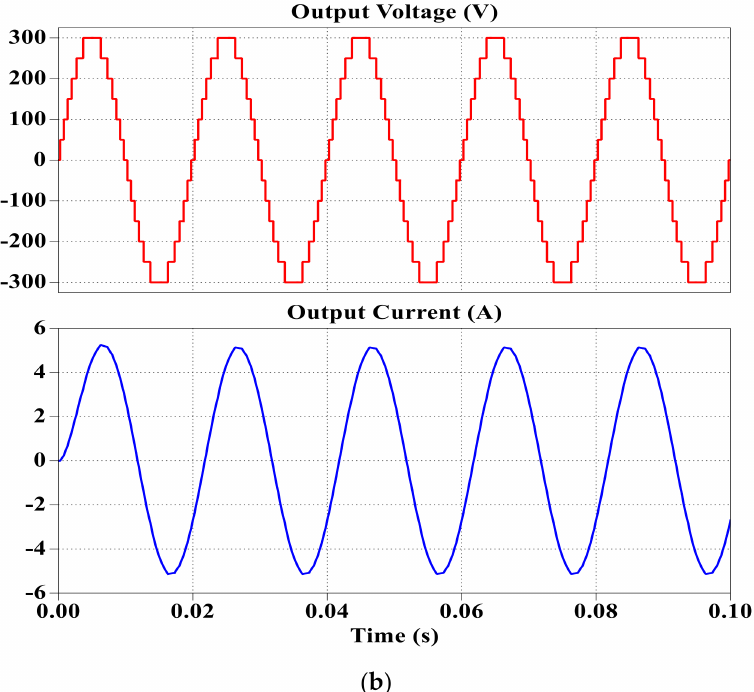
Figure 7. Simulation results ( a ) Terminal voltage and Load current for R load. ( b ) Terminal voltage and Load current for R-L